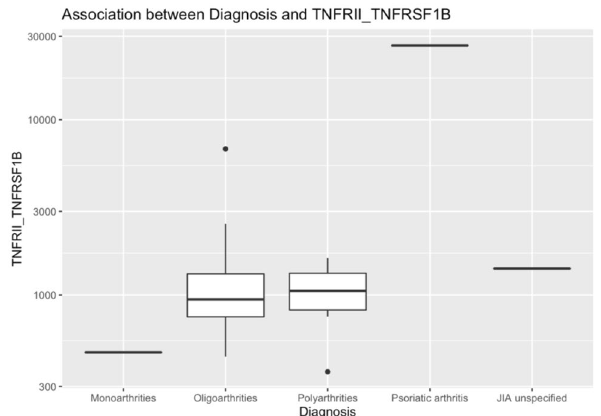
Figure 3. This figure illustrates the association between protein levels of TNFRSF1B (tumor necrosis factor receptor superfamily member 1B) and the different sub-diagnoses of JIA in 30 children with JIA: Only psoriatic arthritis could reveal a significant association.